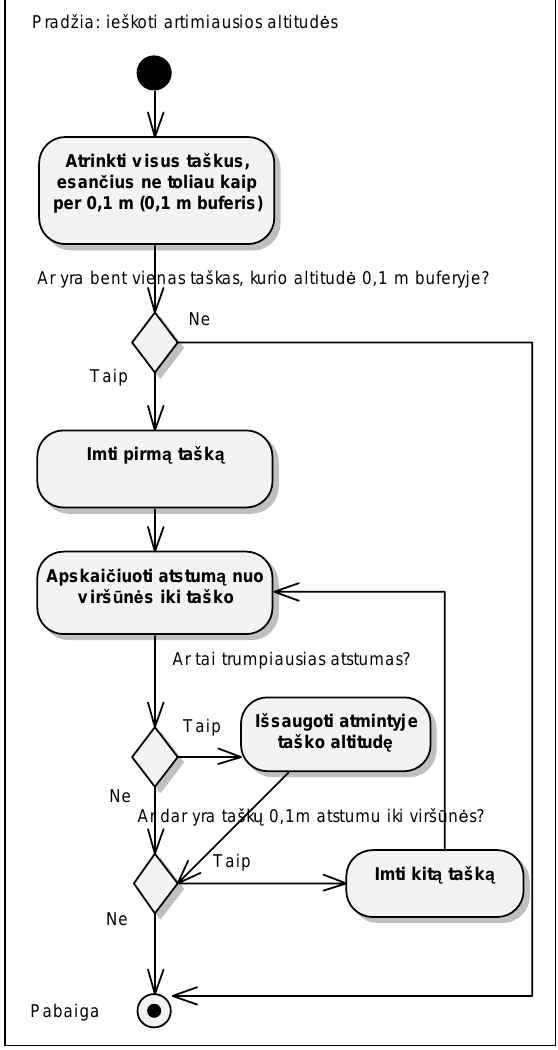
Fig 3. Algorithm diagram of the closest altitude determination Interpoliavimo rezultatai pateikti 4 lentel ė je.